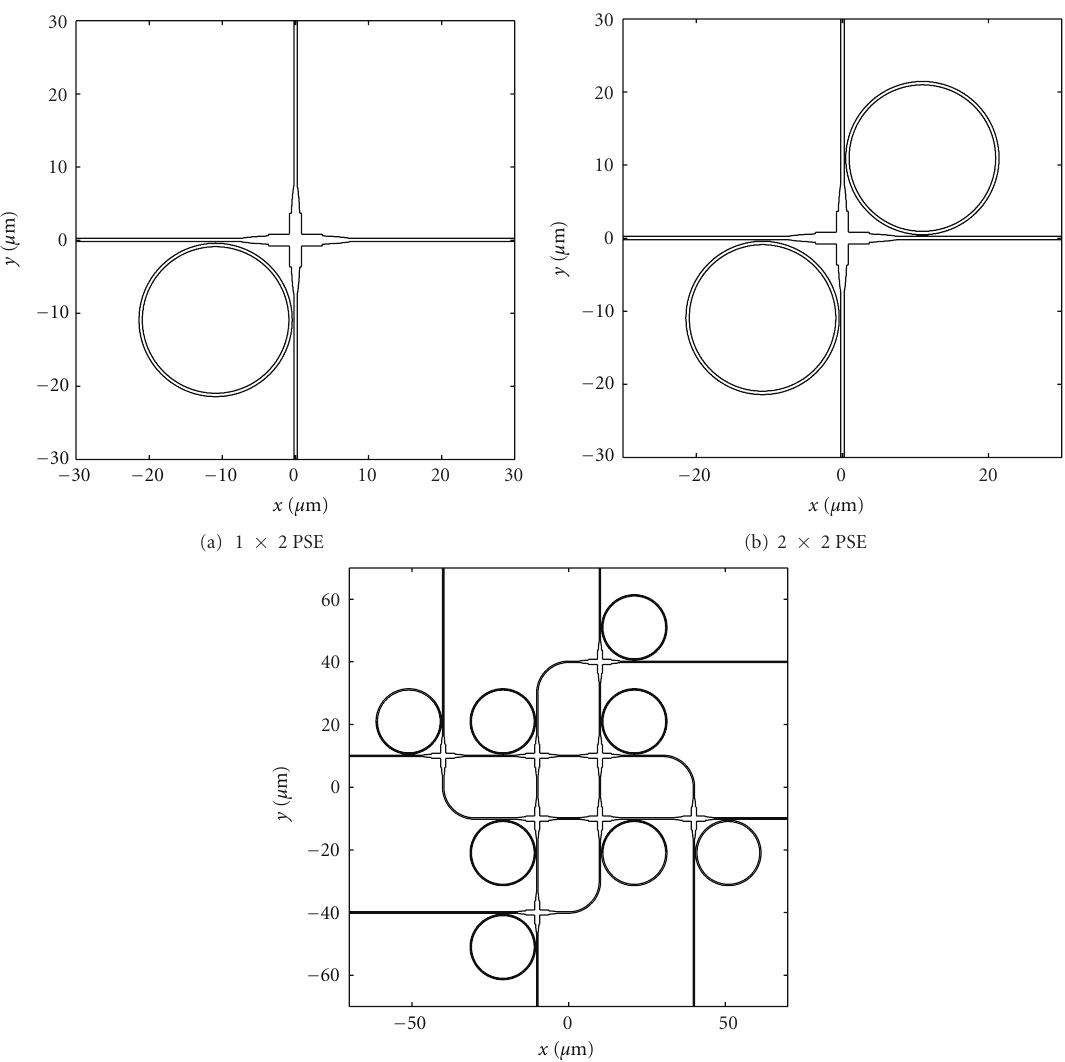
Figure 1: Sketch of a microring-based (a) 1 × 2 PSE, (b) 2 × 2 PSE, and (c) 4 × 4 optical switch. As one can observe, complex structures are obtained by compositions of the elementary building